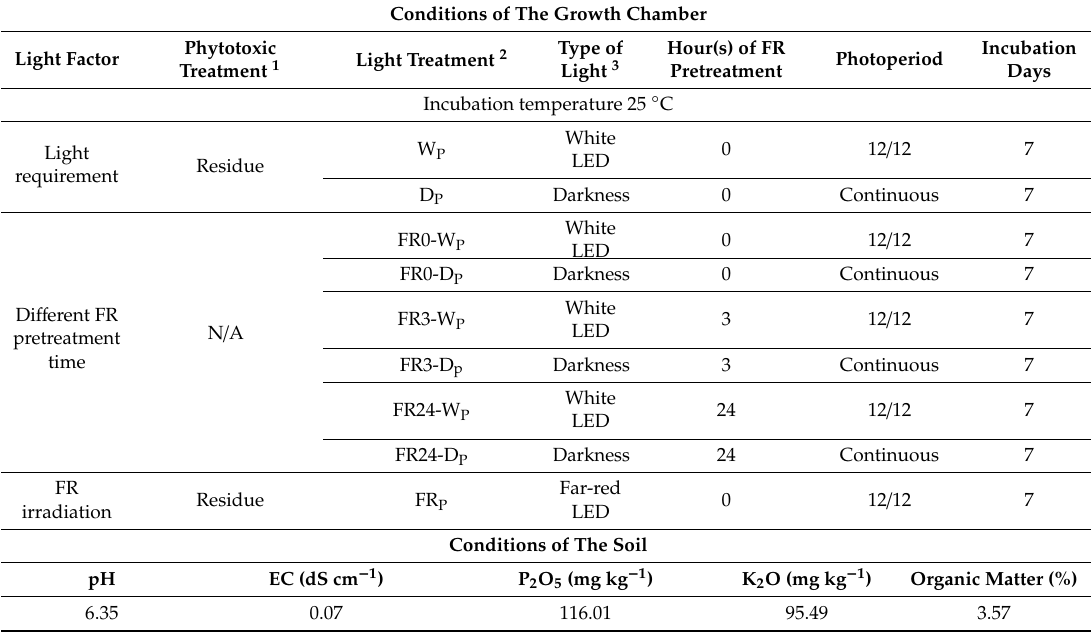
Table 2. The experimental conditions of the pot